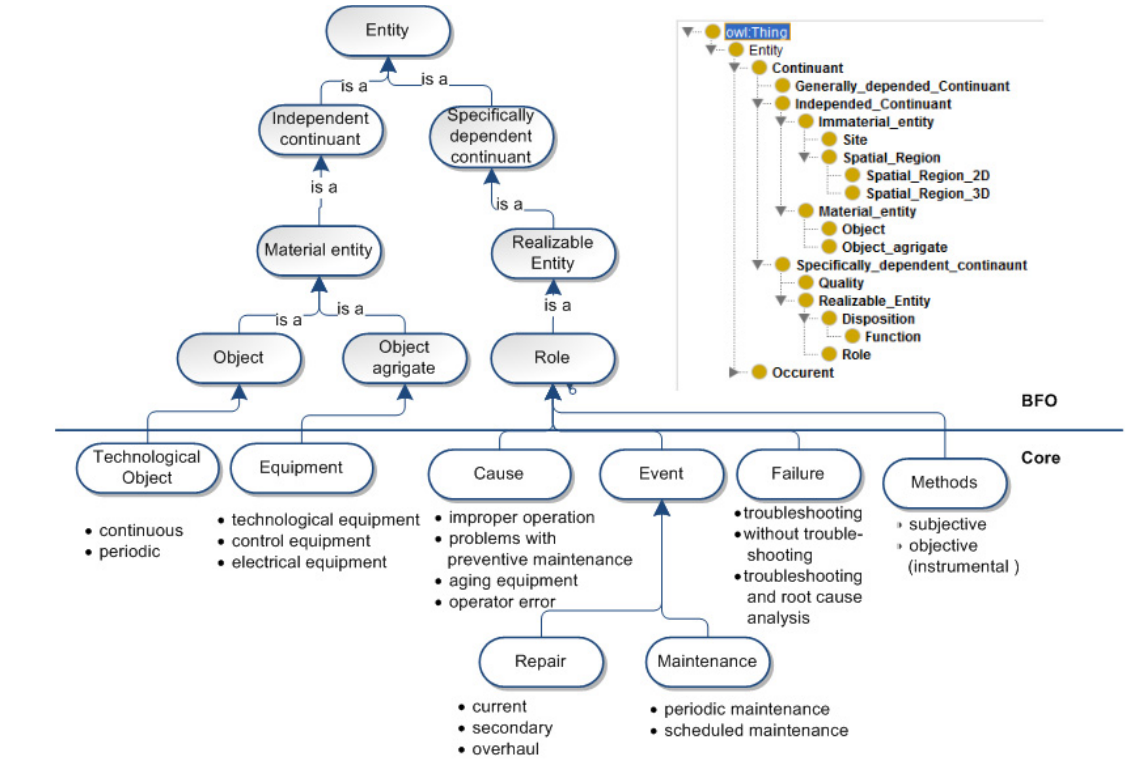
Figure 2. Fragment of BFO and core.